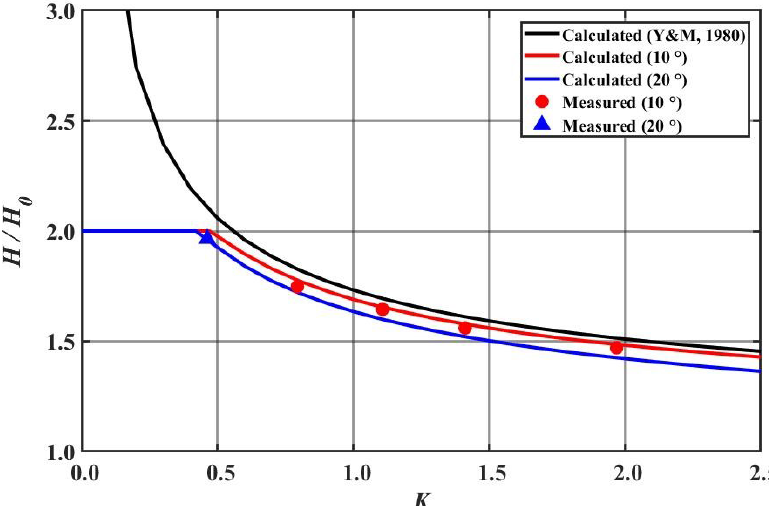
Figure 11. Comparison of calculated and measured normalized wave heights along the wall as a function of nonlinear parameter K . Black solid curve represents the wave height predicted by shock theory of Yue and Mei (1980), red and blue solid curves denote the calculated wave heights for θ 0 = 10 and 20 ◦ , respectively. Symbols are measured